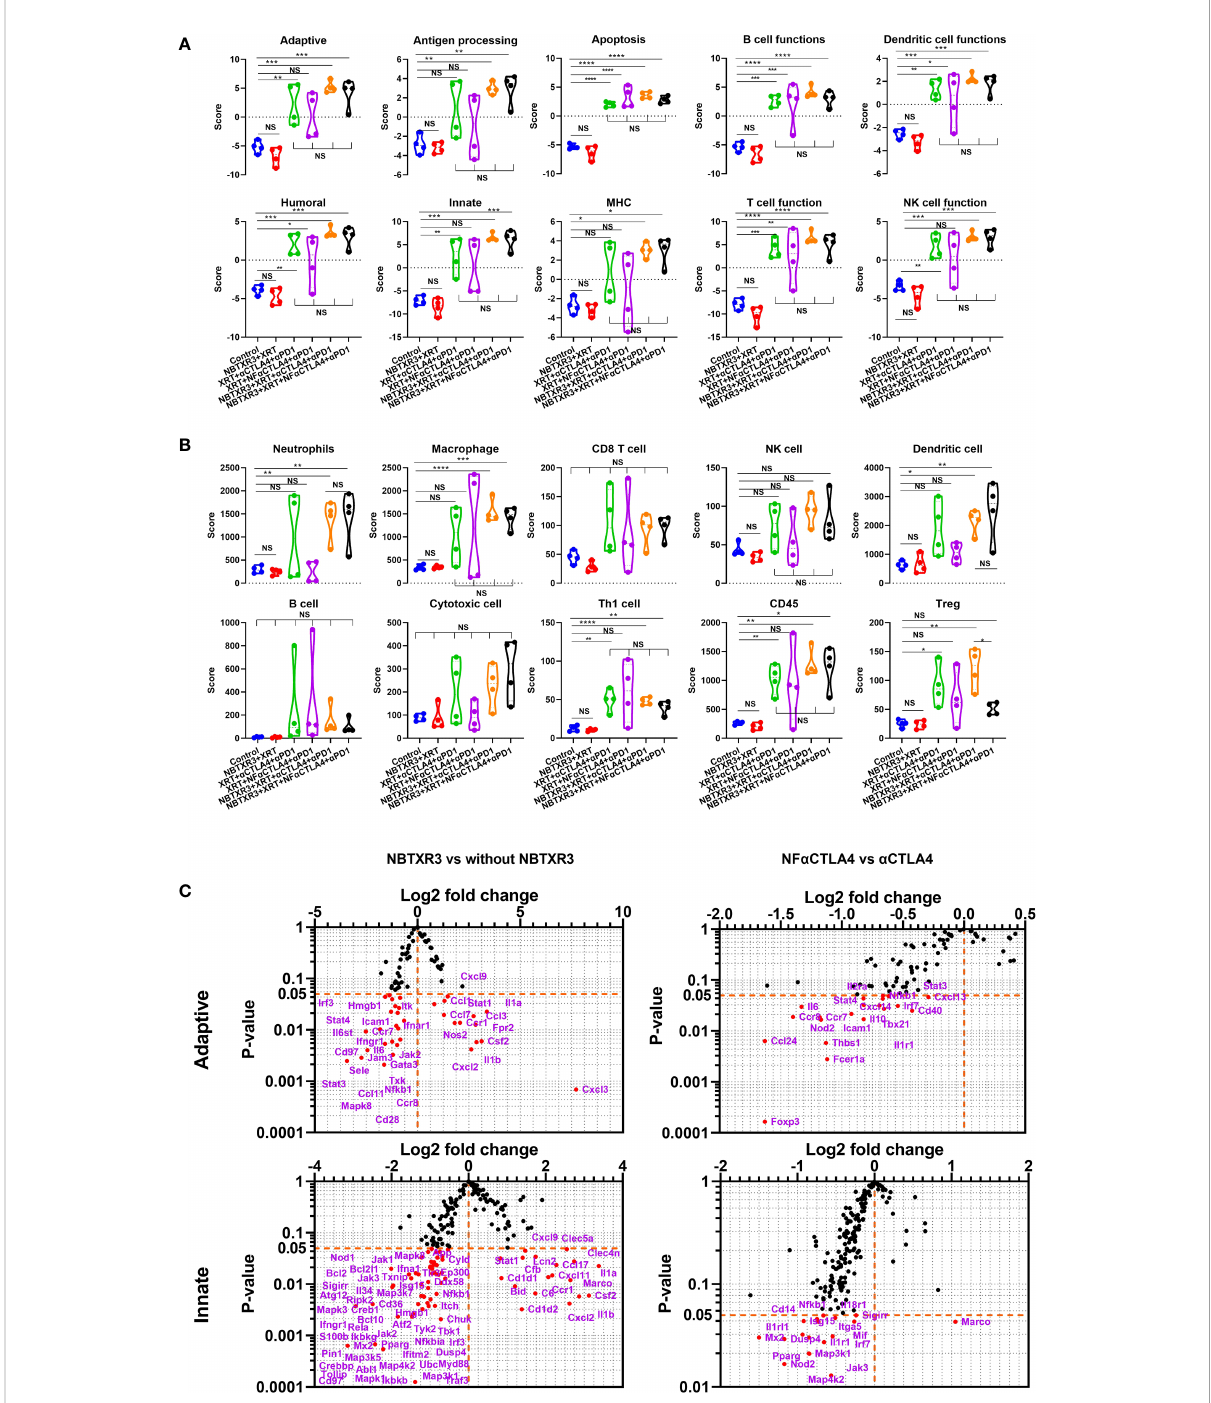
FIGURE 4 NBTXR3, combined with NF- a CTLA4, reduces Treg abundance and promotes antitumor immune response in the secondary tumor. (A) Activities of immune pathways in the secondary tumors. (B) Score of immune cell abundance in the secondary tumor. (C) Changes in gene expression in adaptive and innate immune pathways. Mice bearing 344SQR tumors were treated with various immunoradiotherapies in Figure 1A, and the secondary tumors were harvested on day 18. The RNA extracted from the tumors was analyzed by an nCounter PanCancer Immune Pro fi ling Panel. Data are expressed as means± SEM. P<0.05 was considered statistically signi fi cant. *P<0.05, **P<0.01, ***P<0.001, ****P<0.0001, NS, not signi fi